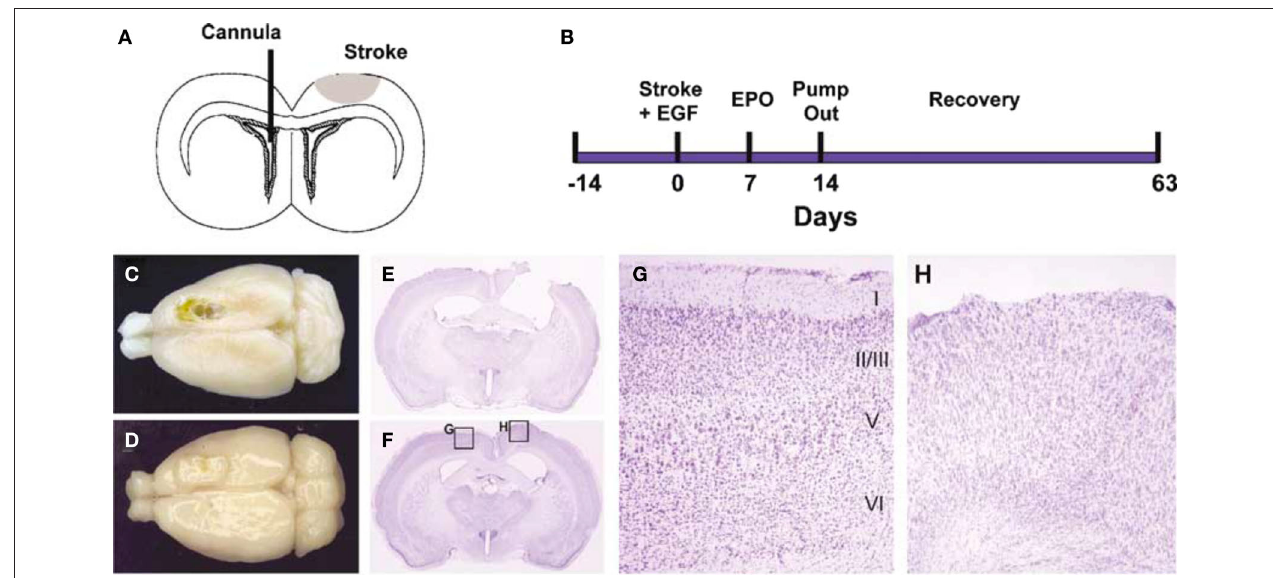
whereas treatment with EGF + EPO led to the development of newly generated cortical tissue. (E–H) Coronal cresyl violet-stained sections showing the lesion cavity in a CSF + CSF lesion brain (E) and an EGF + EPO lesion brain (F) . The lesion cavity is filled with tissue in the latter brain. The intact hemisphere of the EGF + EPO brain has clear lamination characteristic of motor cortex (g) but there is no obvious organization in the newly generated cortical tissue and a complete absence of a layer I (H) (modified from Kolb et al.,